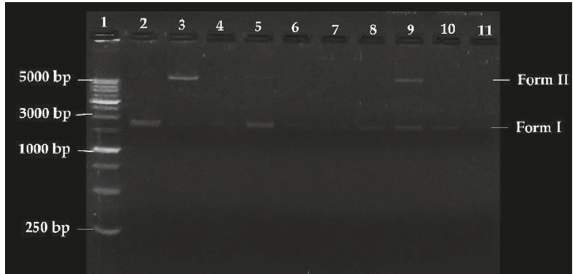
Figure 8: Agarose gel electrophoretic pattern of the pmCherry vector extracted from E. coli (5ng varying concentrations of compounds 3 and 4 . Lane 1: HyperLadder 1kb (15 μ L); Lane 2: pmCherry; Lane 3: pmCherry+H 2 O 2 ; Lanes 4 and 8: pmCherry+compound (60 μ mol